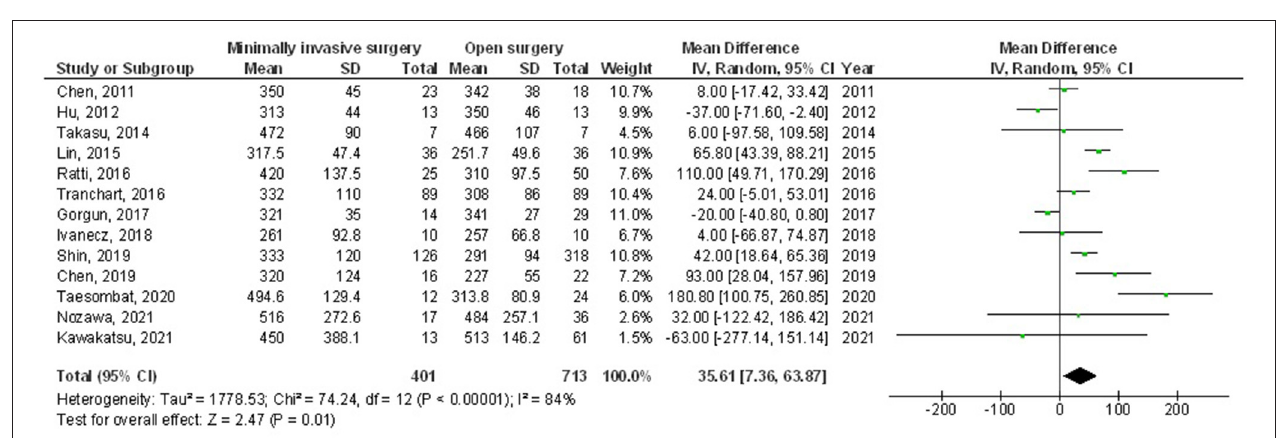
suggesting the need for more studies comparing minimally invasive surgery to open surgery in subjects with colorectal cancer and synchronous colorectal liver metastases to validate the effect